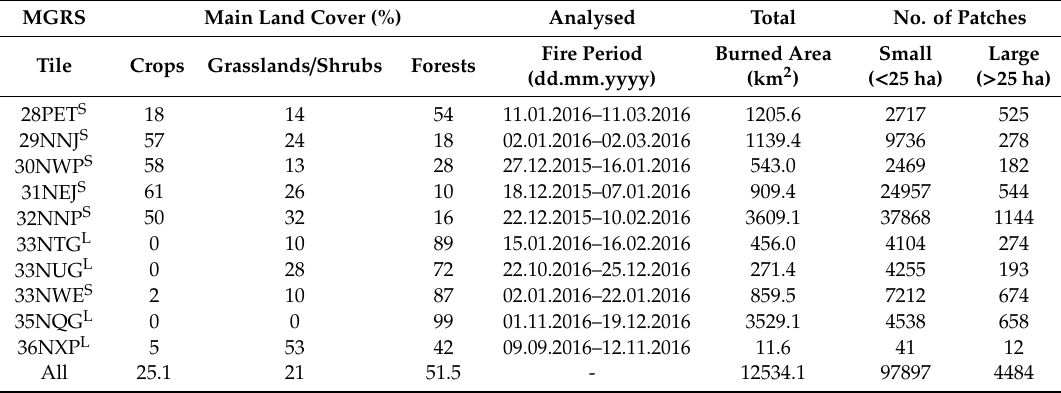
Table 1. Military Grid Reference System (MGRS) tiles used for inter-comparison. The main land cover type (from CCI Land Cover product, 2015) and the total burned area. The sensor used to generate the reference fire perimeters was labelled S for Sentinel-2 and L for